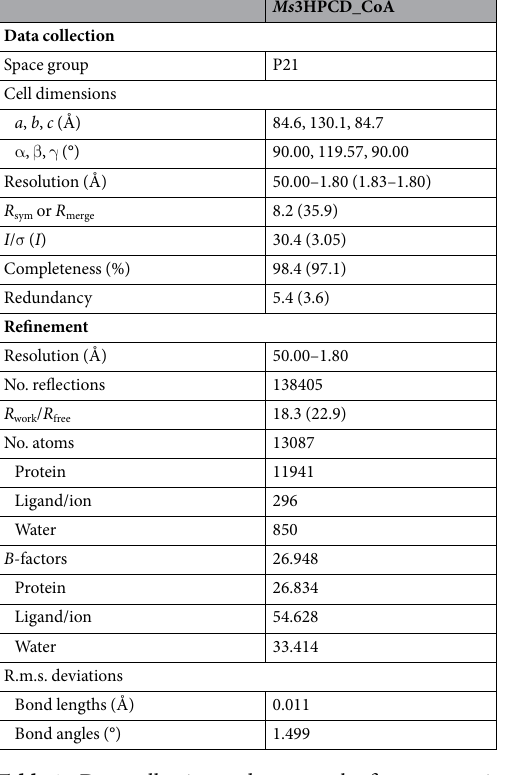
Table 1. Data collection and structural refinement statistics. a The numbers in parentheses are statistics from the highest resolution shell. b R sym = Σ |Iobs − Iavg|/ Iobs, where Iobs is the observed intensity of individual reflection and I avg is average over symmetry equivalents. c R work = Σ ||Fo| − |Fc||/ Σ |Fo|, where |Fo| and |Fc| are the observed and calculated structure factor amplitudes, respectively. R free was calculated with 5% of the